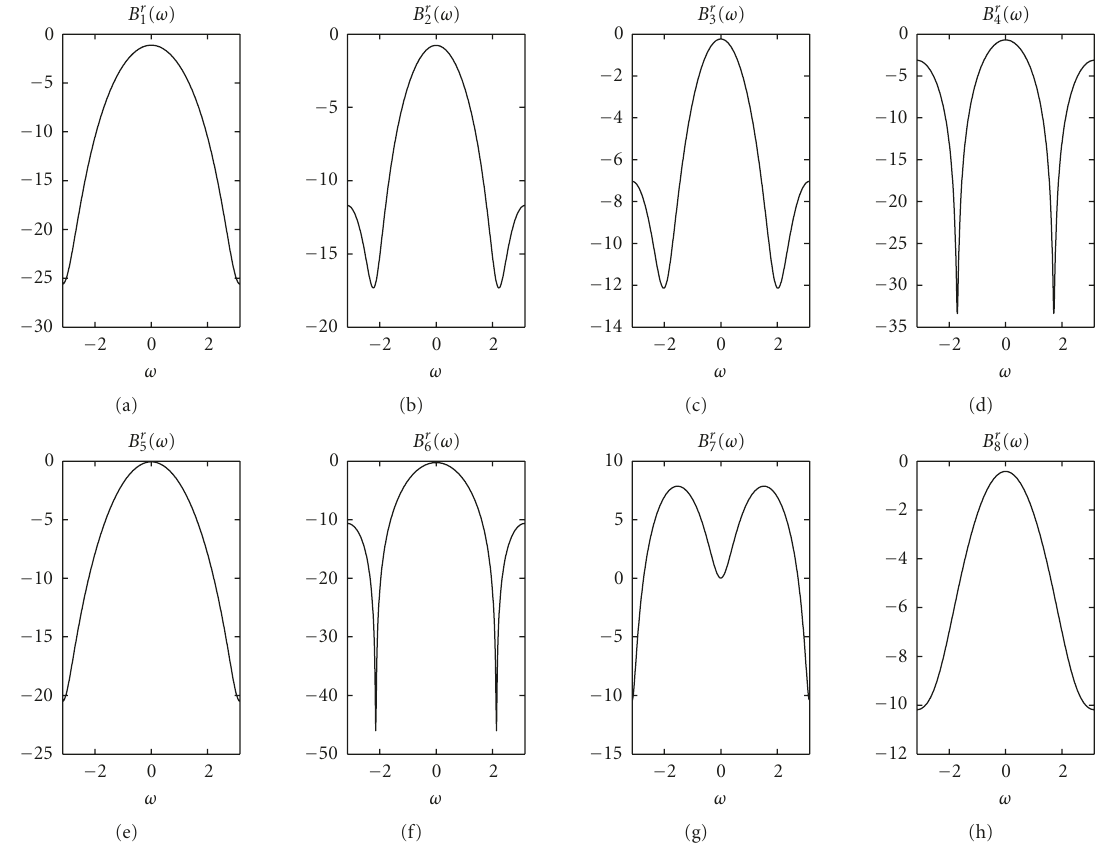
Figure 6: Equivalent filter frequency responses for RBOSR algorithm coe ffi cients. Frequency responses of B 1 – B 8 are shown in dB